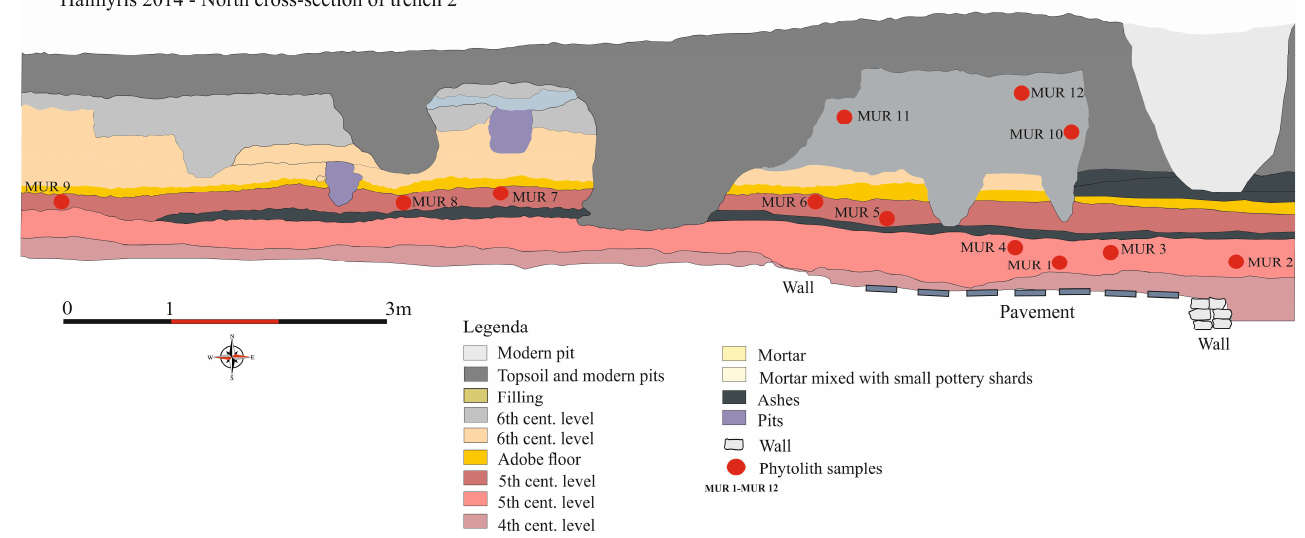
Figure 7. Halmyris, Romania, 2014, extramuros area. The location of phytolith samples in the north cross section of trench 2.